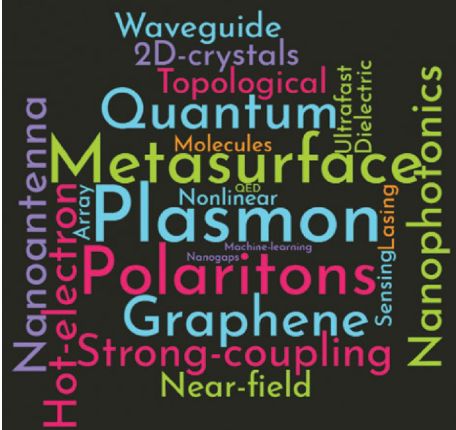
Fig. 1 The breadth of research topics and directions within plasmonics illustrated by a word cloud compiled from the book of abstract from the 9th International Conference on Surface Plasmon Photonics (SPP9) held in 2019